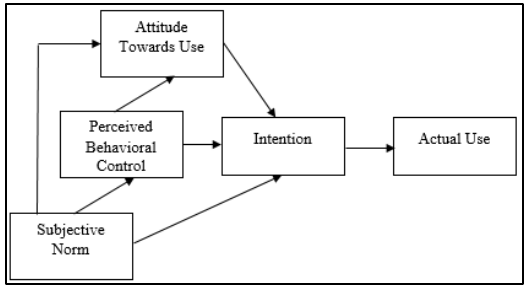
Figure 3. Planned Behavior Theory